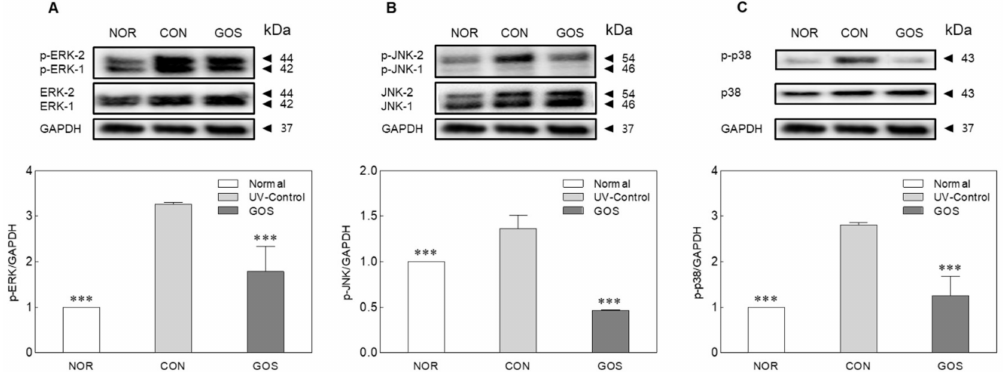
Figure 5. E ff ect of galacto-oligosaccharide (GOS) intake on the phosphorylated extracellular signaling regulated kinase (ERK, A ), Jun N-terminal kinase (JNK, B ) and p38 ( C ) levels in ultraviolet (UV) B-irradiated hairless mice, as determined by Western blotting. Data are expressed as mean ± standard deviation, and di ff erent symbols indicate significant di ff erences at *** p < 0.001 vs. CON group. Normal (NOR; unirradiated mice); ultraviolet (UV) B control (CON; irradiated and untreated mice); CTP